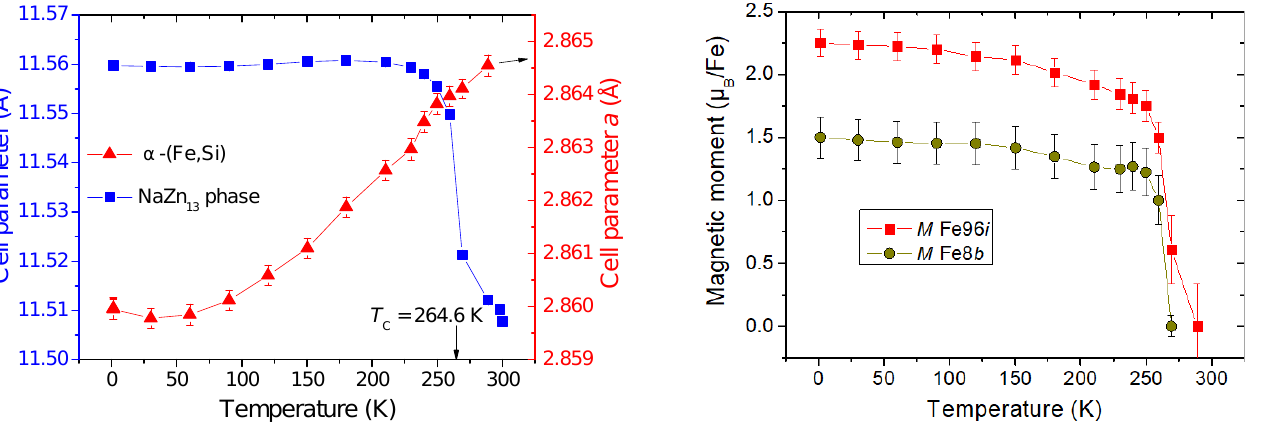
Figure 10. ( Left ) Evolution of the deuteride LaFe 11.5 Si 1.5 D 0.7 cell parameter versus temperature derived from neutron diffraction. ( Right ) Magnetic moments of Fe atoms versus temperature, in the 96 i and 8 b crystallographic sites